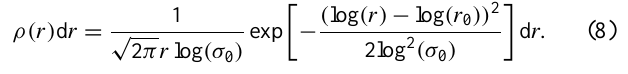
Figure 2. Sensitivity s to Lambertian laminar reflectance of albedo ω 0 = 1 at height z above a black surface in a purely absorbing atmo- sphere ( θ Sun = θ View = 0) as a function of total column absorption strength, τ abs , 0 (assuming an exponential concentration profile of scale height H = 8 and uniform absorption cross section at all lev-